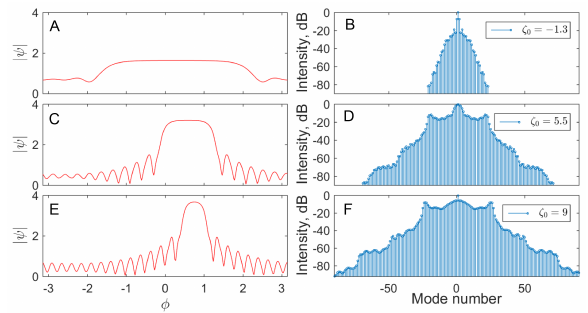
Figure 19: (A, C, E) Numerically simulated platicons in normal dis- persion microresonators for different values of laser detuning. (B, D, F) Corresponding optical spectra for the same set of parameters. Adapted from Ref. [55]. Refer to [55] for the details of simulation